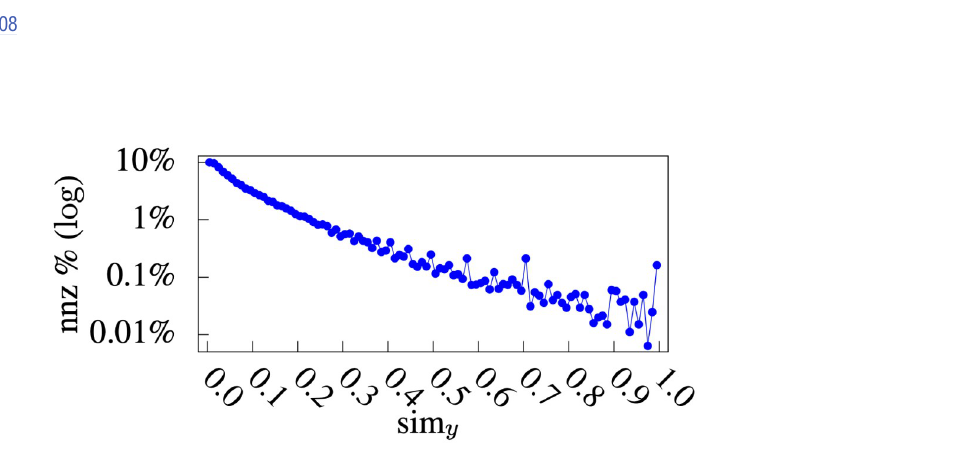
Fig 10. Physician-physician similarity